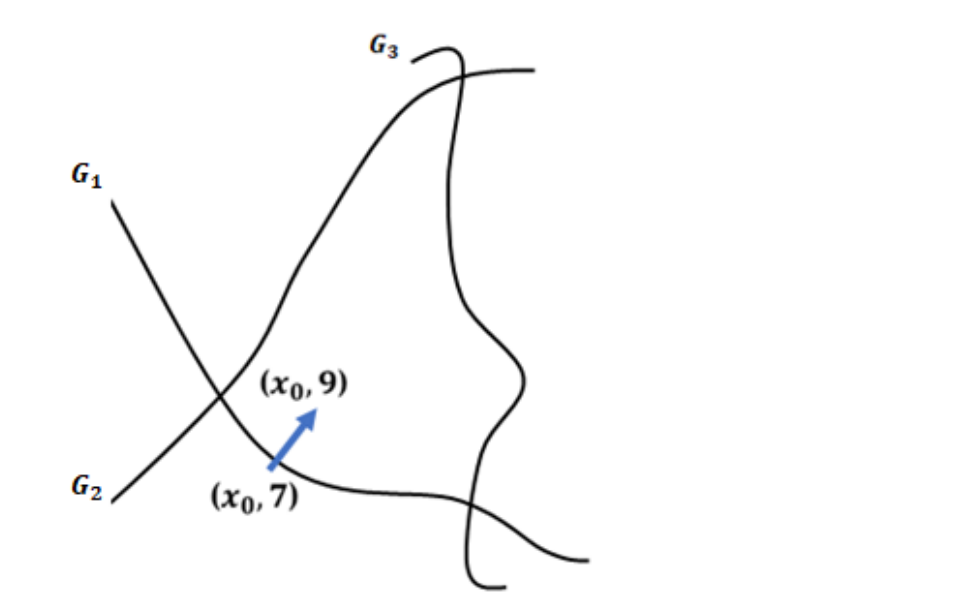
Figure 20. JSMA variant JSMA + F based on the logit saliency map. The JSMA is effective in fooling neural network models by only modifying a small number of input features.